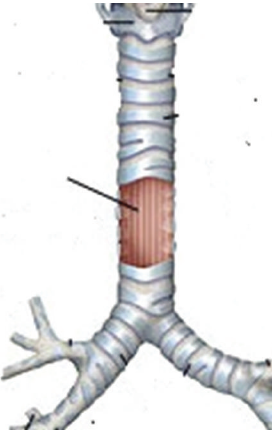
Figure 3: Location of the tracheal tear in the distal trachea.